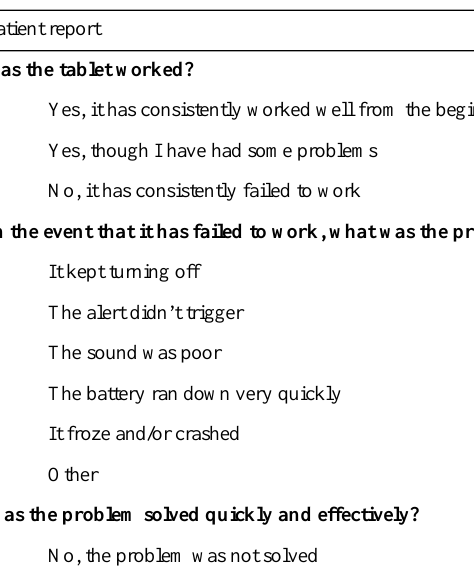
Table 4. Patient assessment of the ALICE